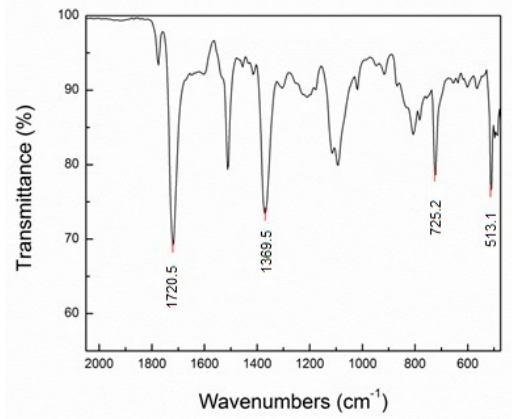
Figure 2. FTIR spectrum obtained from the polyimide foam.